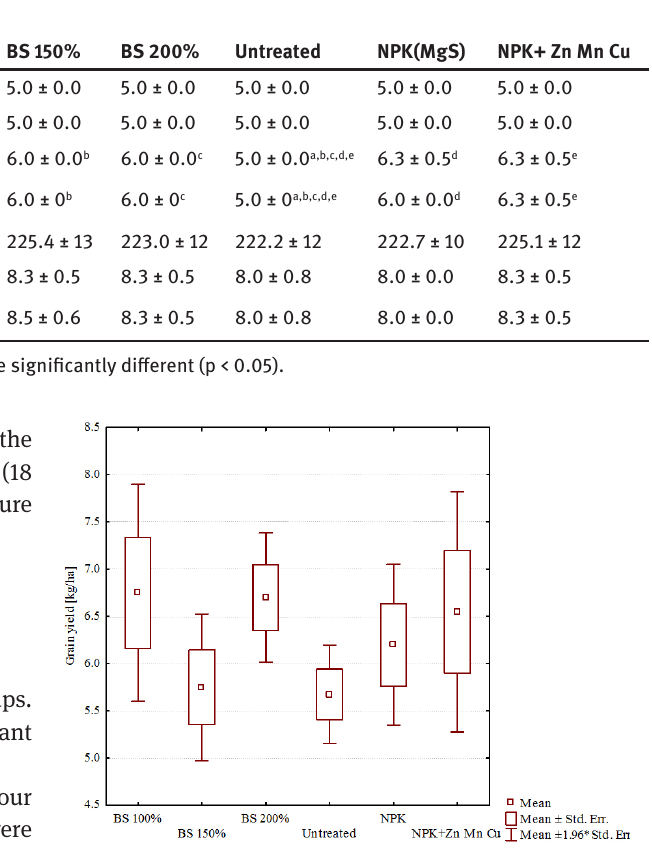
Figure 1: Grain yield vs.